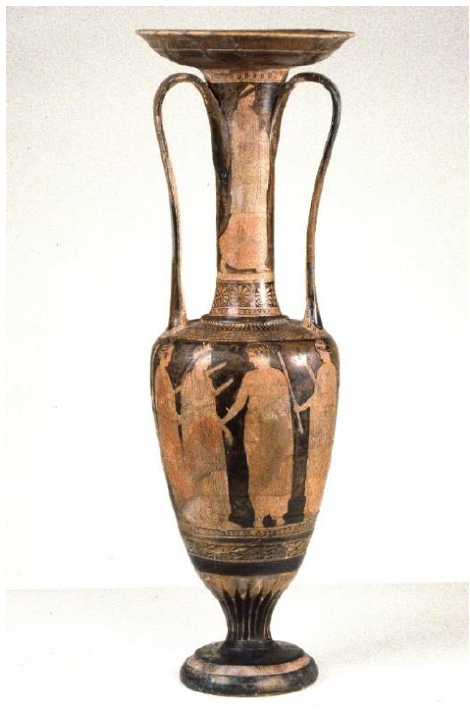
Figure 9. Depictions of weddings and wedding preparations on Athenian vases, including all known provenances. Data from the BAPD. Chart created by author.